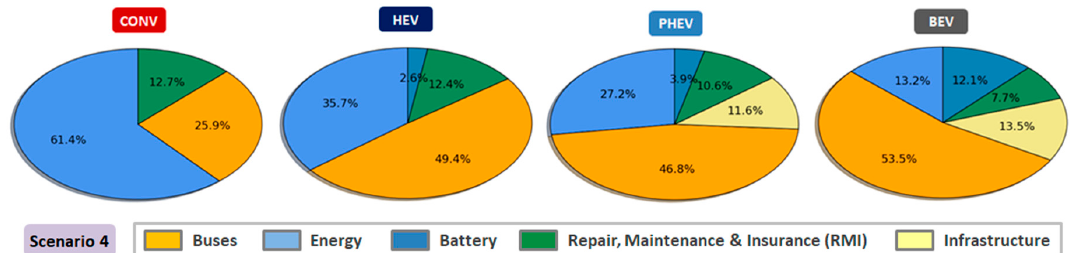
ff erent type of bus fleets and Scenario 4 from Figure 18. Energies 2020 , 13 , x FOR PEER REVIEW